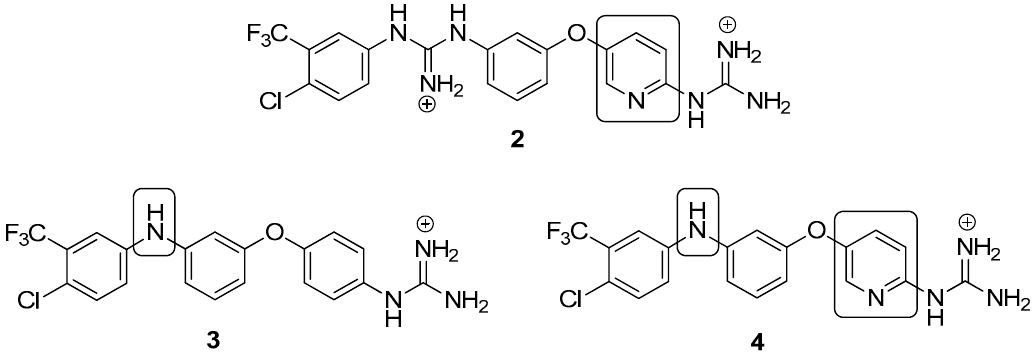
Figure 2. Structures of the proposed new derivatives of 1 (compounds 2 , 3 and 4 ), which docking to the in-house triphosphate (TP)-containing BRAF simplified model was studied.